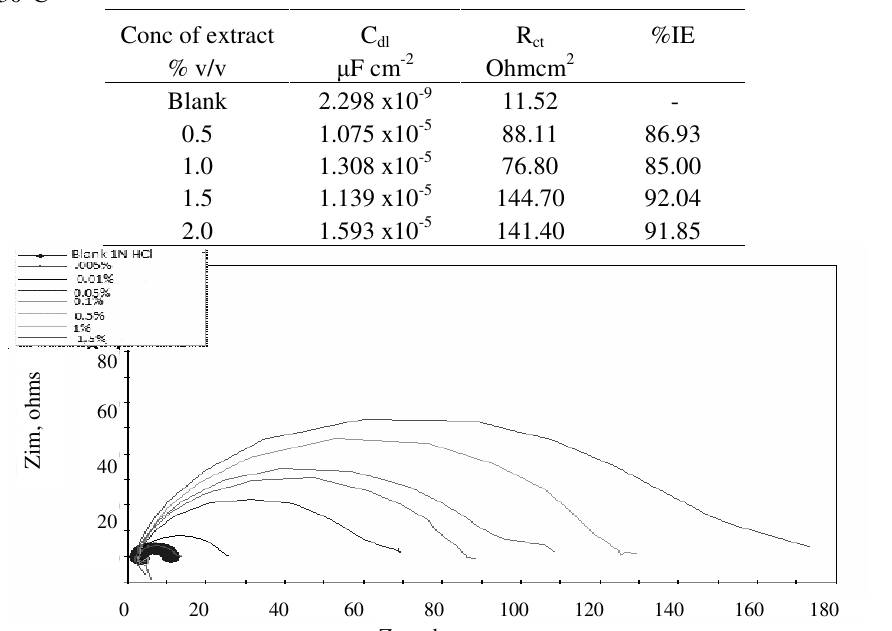
Table 4. EIS parameters for the corrosion of mild steel in 1 N HCl containing MNP extract at 30°C